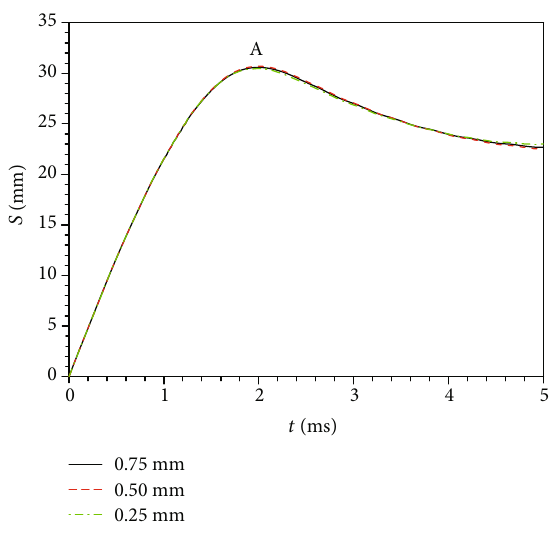
Figure 11: Displacement-time curves of the ascending object of metal tubes displaced at di ff erent places.